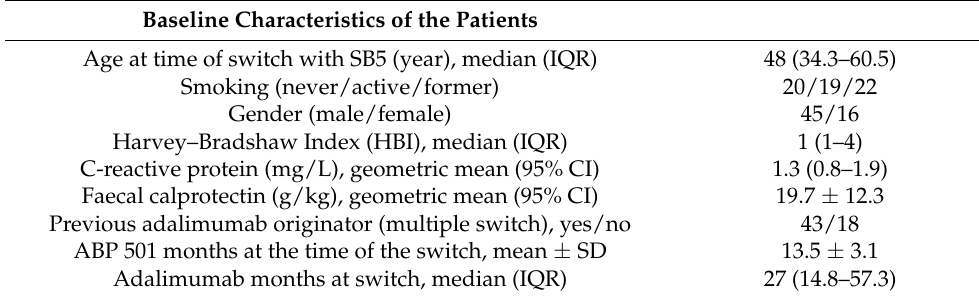
Table 1. Baseline demographic characteristics of patients undergoing switch from ABP 501 to SB5 ( n =